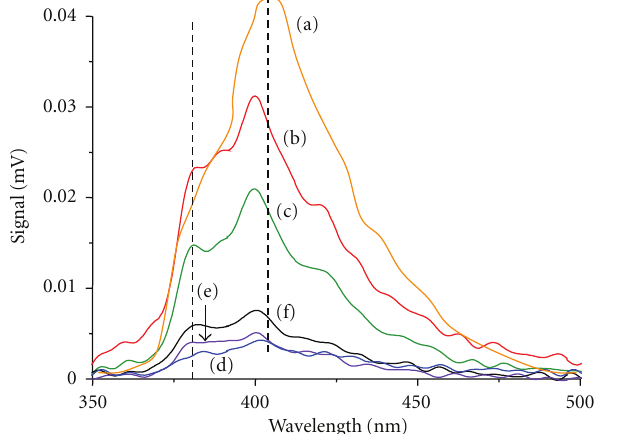
Figure 6: The PL spectra of six photocatalysts as-synthesized. (a) TiO 2 , (b) Cu(0.1)-Ti(0.9)O 2 , (c) Cu(0.07)-Ag(0.03)Ti(0.9)O 2 , (d) Cu(0.05)-Ag(0.05)Ti(0.9)O 2 , e) Cu(0.03)-Ag(0.07)Ti(0.9)O 2 , and (f) Ag(0.1)-Ti(0.9)O 2